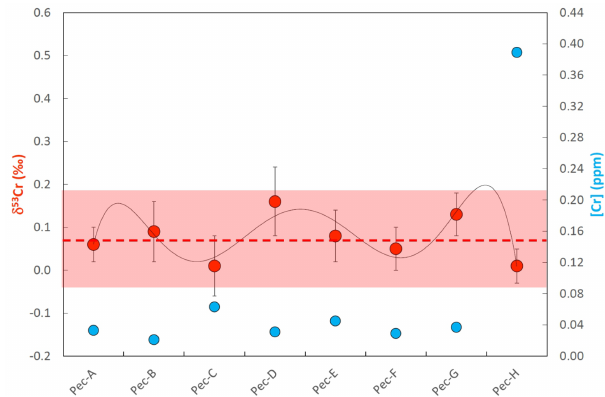
Figure 7. Plot showing the chromium concentrations ([Cr]; blue filled symbols) and chromium isotope compositions ( δ 53 Cr; red filled symbols) of samples along a growth transect in a Mimach- lamys townsendi specimen from Hawke’s Bay. Sample Pec-H is characterized by an elevated [Cr] which is potentially due to an ele- vated organic content in the initial growth zone comprising the apex or hinge of the shell (cf. Fig. 2). For details refer to the text. mix. All data define an average δ 53 Cr value of 0 . 11 ± 0 . 05